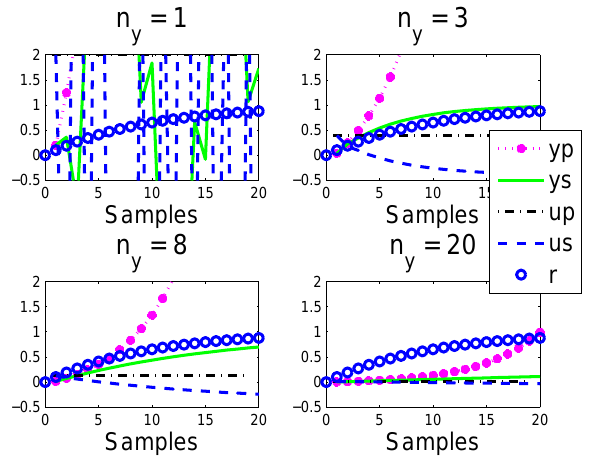
Figure 16. Closed-loop PFC input and output us; ys responses overlaid with predictions up; yp made at the first sample for unstable process G